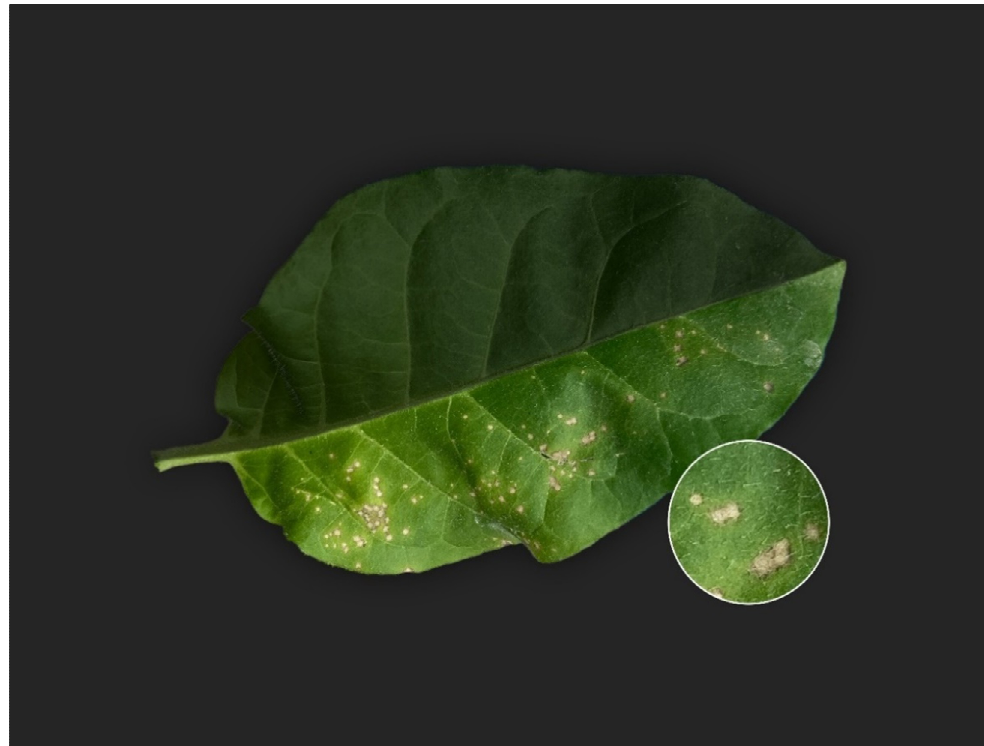
Figure 2 . Necrotic local lesions on N. tabacum cv. Xanthi NN (in this case, 105 local lesions were counted) following mechanical inoculation of one leaf half with Tomato brown rugose fruit virus (ToBRFV).